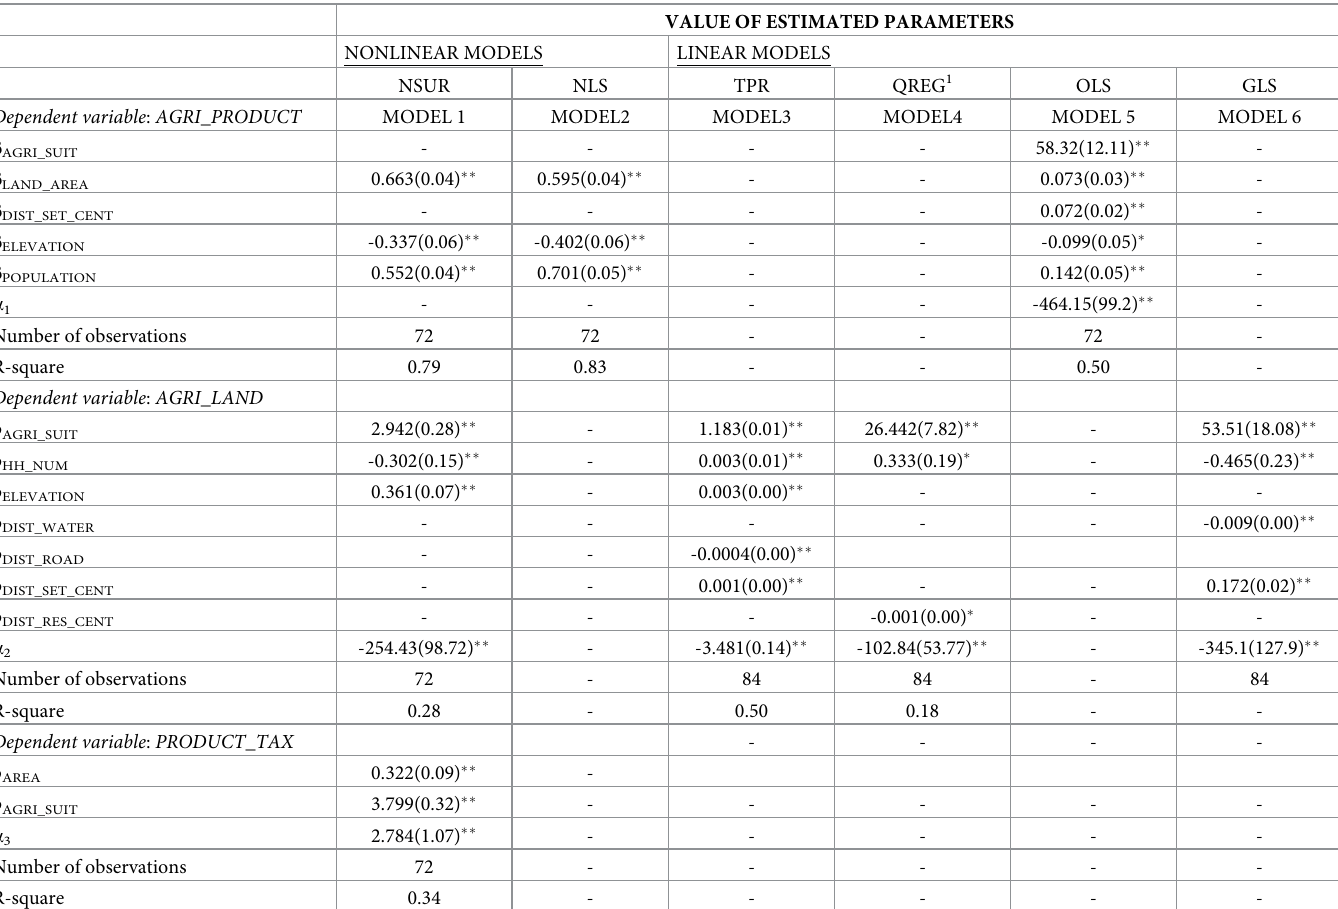
Table 4. Results of the global models estimated for the sample of Bursa